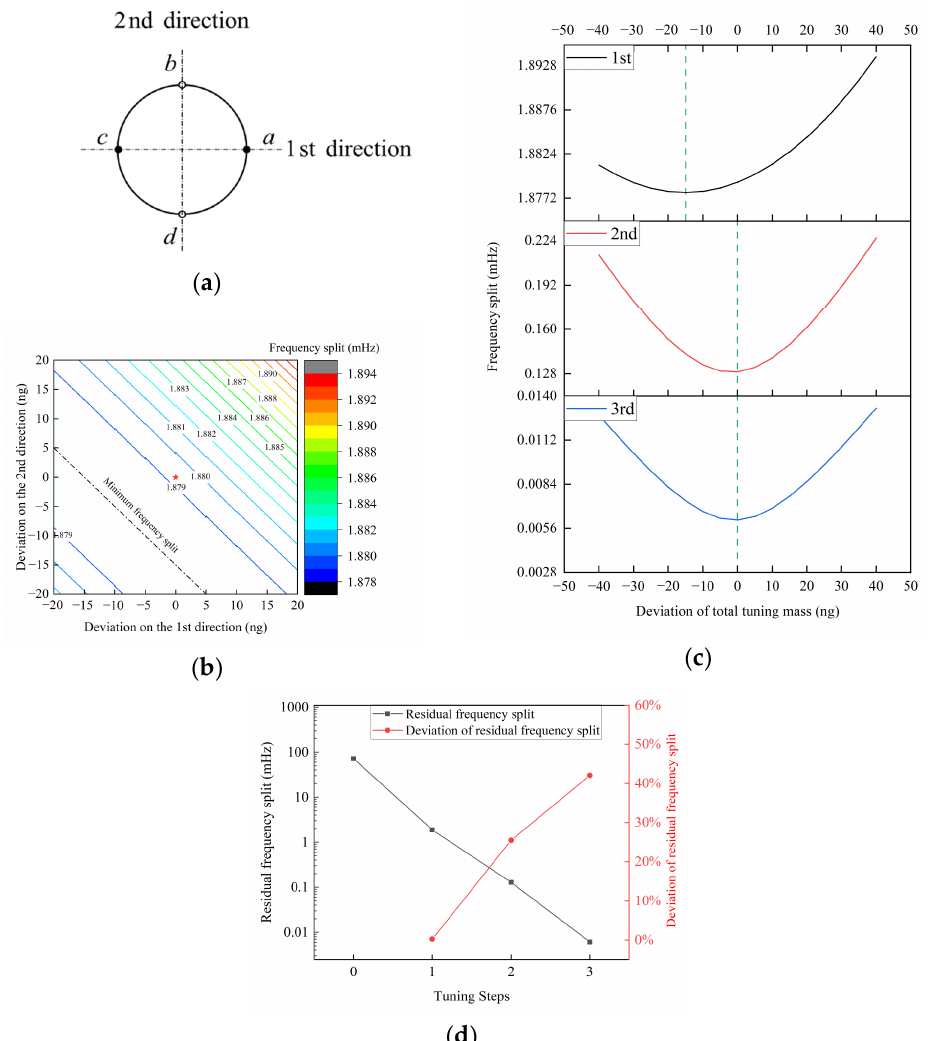
Figure 8. Uncertainty analysis of tuning processes. ( a ) Diagram of two main tuning directions; ( b ) frequency split counter under uncertainty tuning parameters of 1st tuning step; ( c ) frequency split uncertainty during three tuning steps; ( d ) tuning results and performance fluctuation during three round tunings; 0 tuning rounds means initial condition.